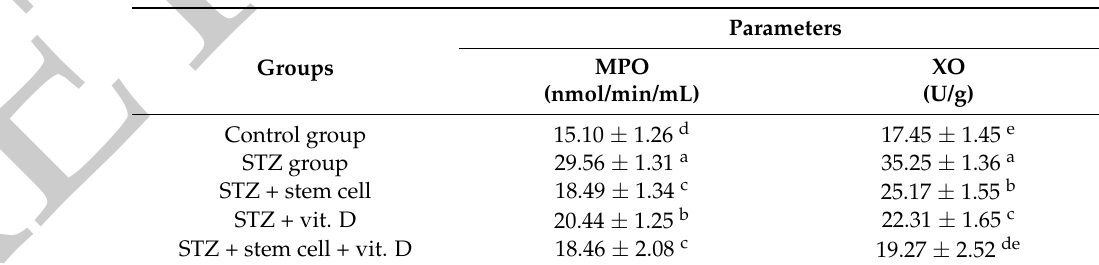
Table 3. Changes in MPO and XO in pancreatic tissues of control and male rats treated with stem cells, vitamin D, and their